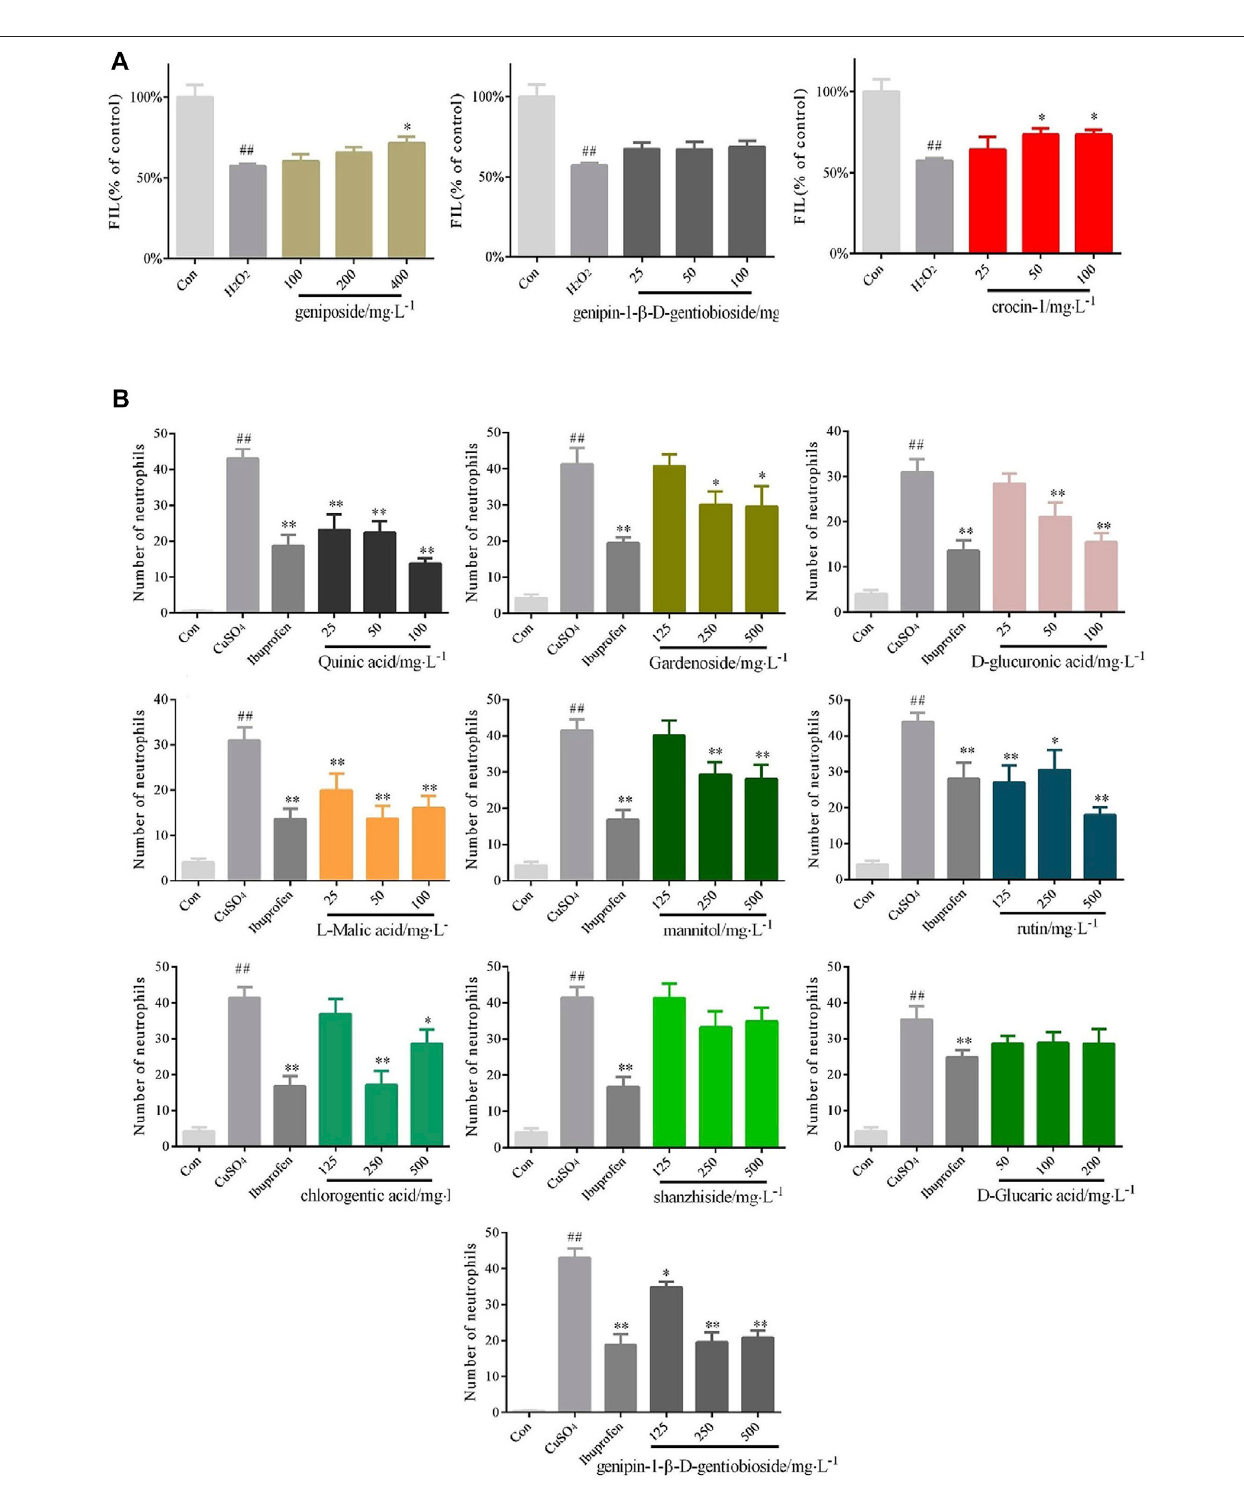
FIGURE 6 | Con fi rmation of the protective effects of the identi fi ed bioactive compounds of GF on liver injury and in fl ammation (A) Quanti fi ed statistical results of protectiveeffectsofgeniposide,genipin-1- β -D-gentiobioside,andcrocin-1withdifferentdosesonliverinjury.n (cid:2) 10 (B) Quanti fi edstatisticalresultsofanti-in fl ammatory effects of quinic acid, gardenoside, D -glucuronic acid, L -malic acid, mannitol, rutin, chlorogenic acid, shanzhiside, D -glucaric acid, and genipin-1- β -D-gentioside with different doses. n (cid:2) 10.